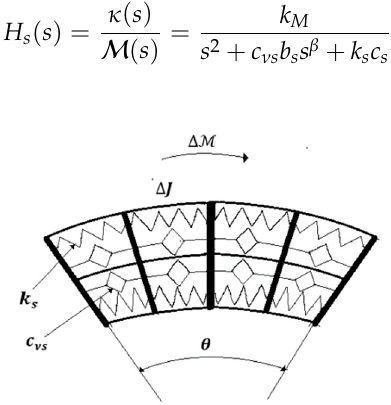
Figure 2. Technological equivalent model of the 3D curvature sensor.